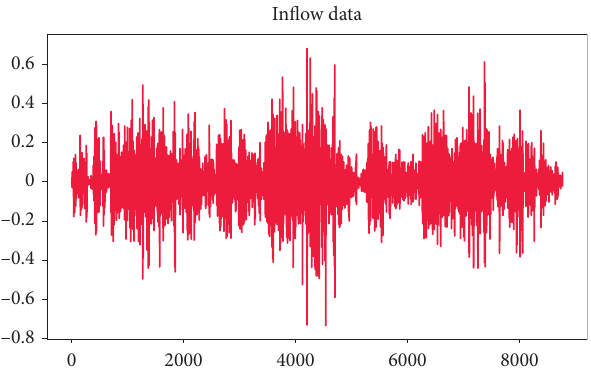
Figure 6: The normalized historical data of